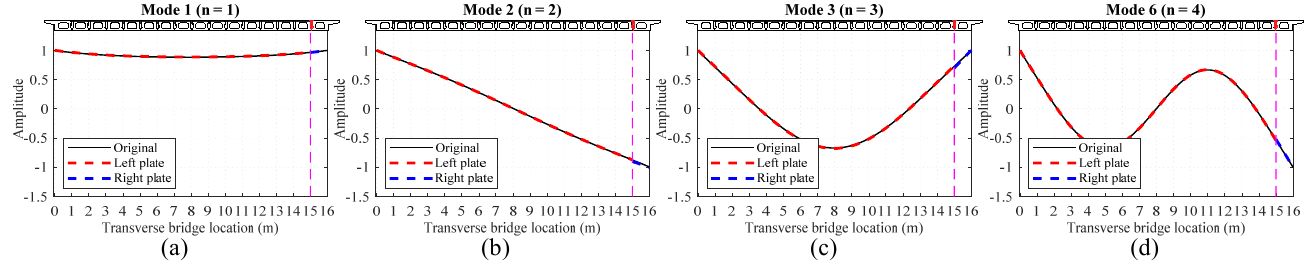
Figure 12. Comparison of the first four transverse modal shapes: hinge position η = 15 m: ( a ) Mode 1, n = 1; ( b ) Mode 2, n = 2; ( c ) Mode 3, n = 3; ( d ) Mode 6, n = 4.